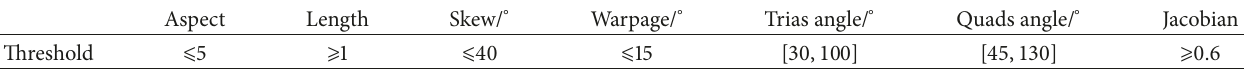
Table 1: Criterion of element check.